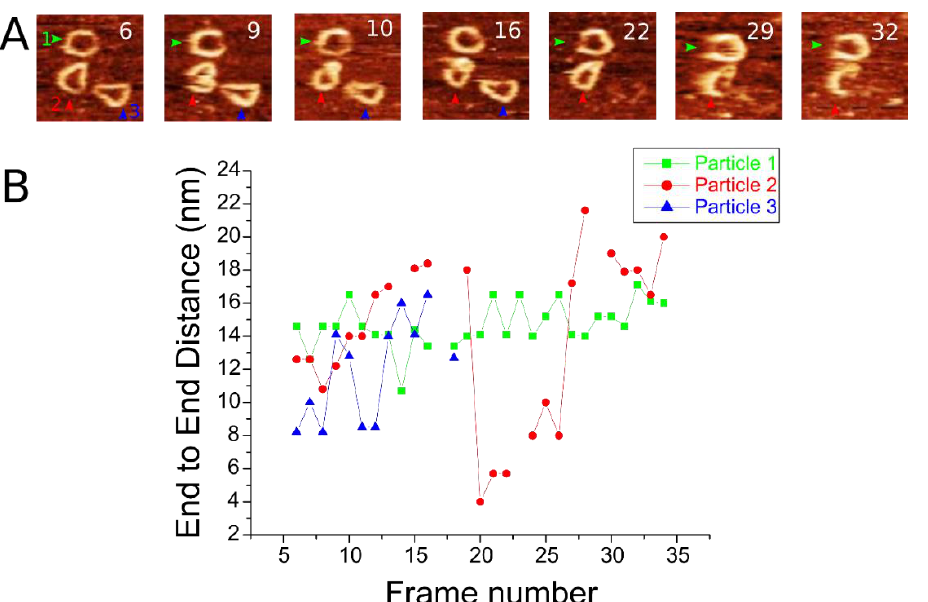
Figure 5. Time-lapse AFM data of nanoring dynamics. ( A ) Selected frames taken from time-lapse experiments following three nanorings. Green arrow indicates particle 1. Red arrow indicates particle 2. Blue arrow indicates particle 3. ( B ) Graph showing the fluctuation of end-to-end distance for each nanoring dependent on the frame number.